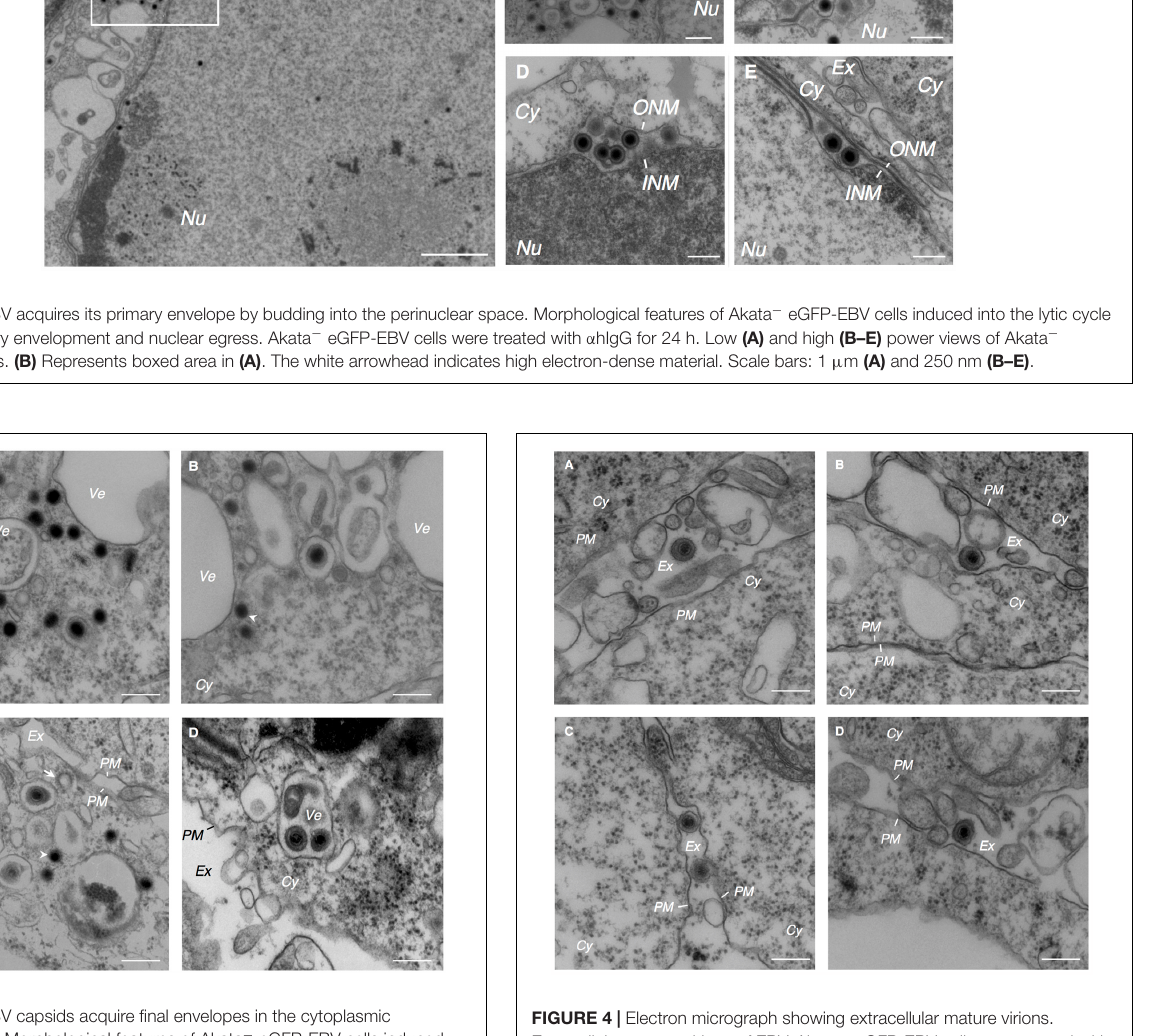
FIGURE 4 | Electron micrograph showing extracellular mature virions. Extracellular mature virions of EBV. Akata − eGFP-EBV cells were treated with that mature virions bud into the GM130-positive cellular compartments, we examined the distribution of GM130 and the EBV viral capsid antigen (VCA)-p18, BFRF3 (van Grunsven et al., 1994; Henson et al., 2009). VCA-p18 distributed in the nucleus diffusely, and in the cytoplasm and the PM in a speckled pattern (green in Figure 5E ). GM130 efficiently colocalized with p18 in the cytoplasm and in the PM (magenta in Figure 5E ). These results indicate that secondary envelopment of EBV takes place in the intracellular compartments containing cis- and TGN